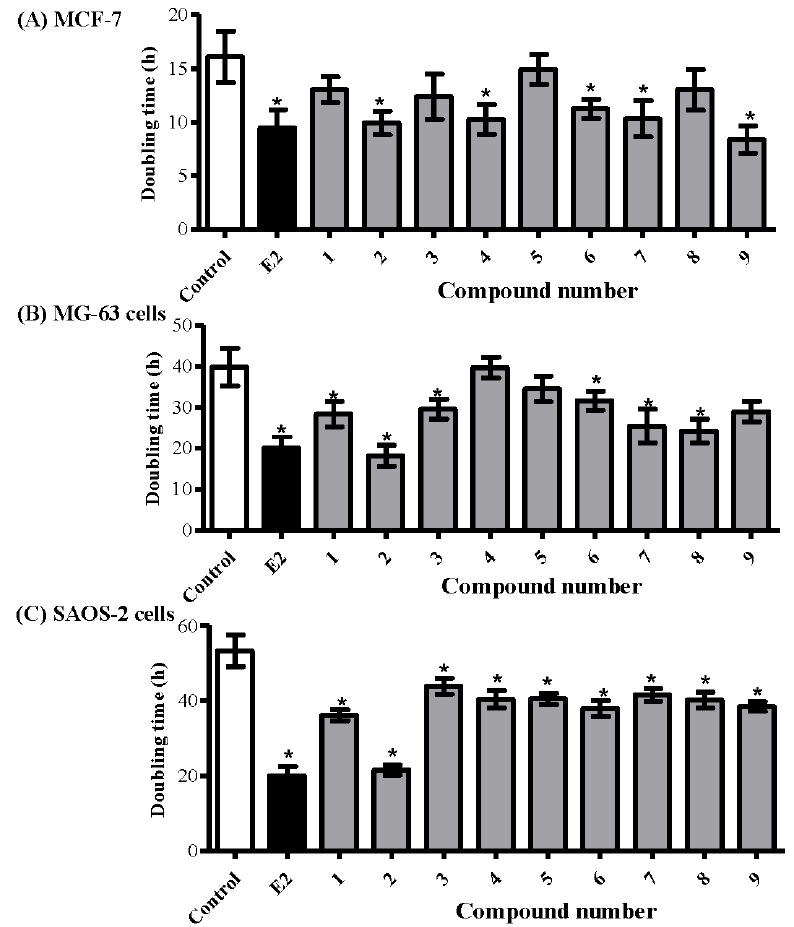
Figure 3. Determining the proliferative effects of compounds isolated from A. meleguta using MCF-7 ( A ); MG-63 ( B ); and SAOS-2 ( C ) cell lines. Cells were treated with test compounds (1 µM) for up to 96 h, and viability was determined using SRB assay. Doubling times were calculated and compared to control untreated cells and E 2 (0.1 µM) treated cells (positive control). Data are expressed as mean ± SD; n = 6. * Significantly different from untreated cells; p < 0.05.